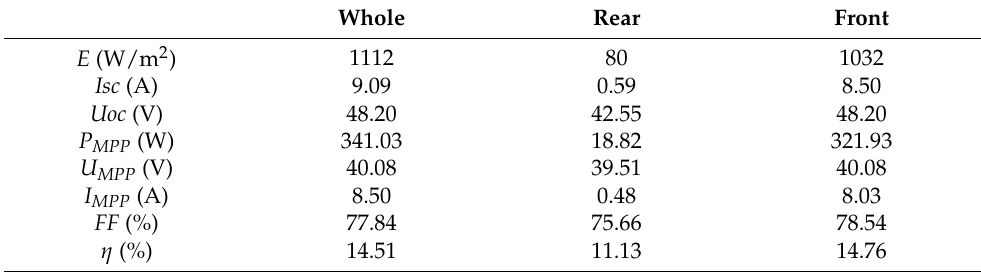
Table 17. The measurements results and calculations for 60 ◦ inclination of the module over the foil substrate, considering the values for the whole-module generation and its rear side